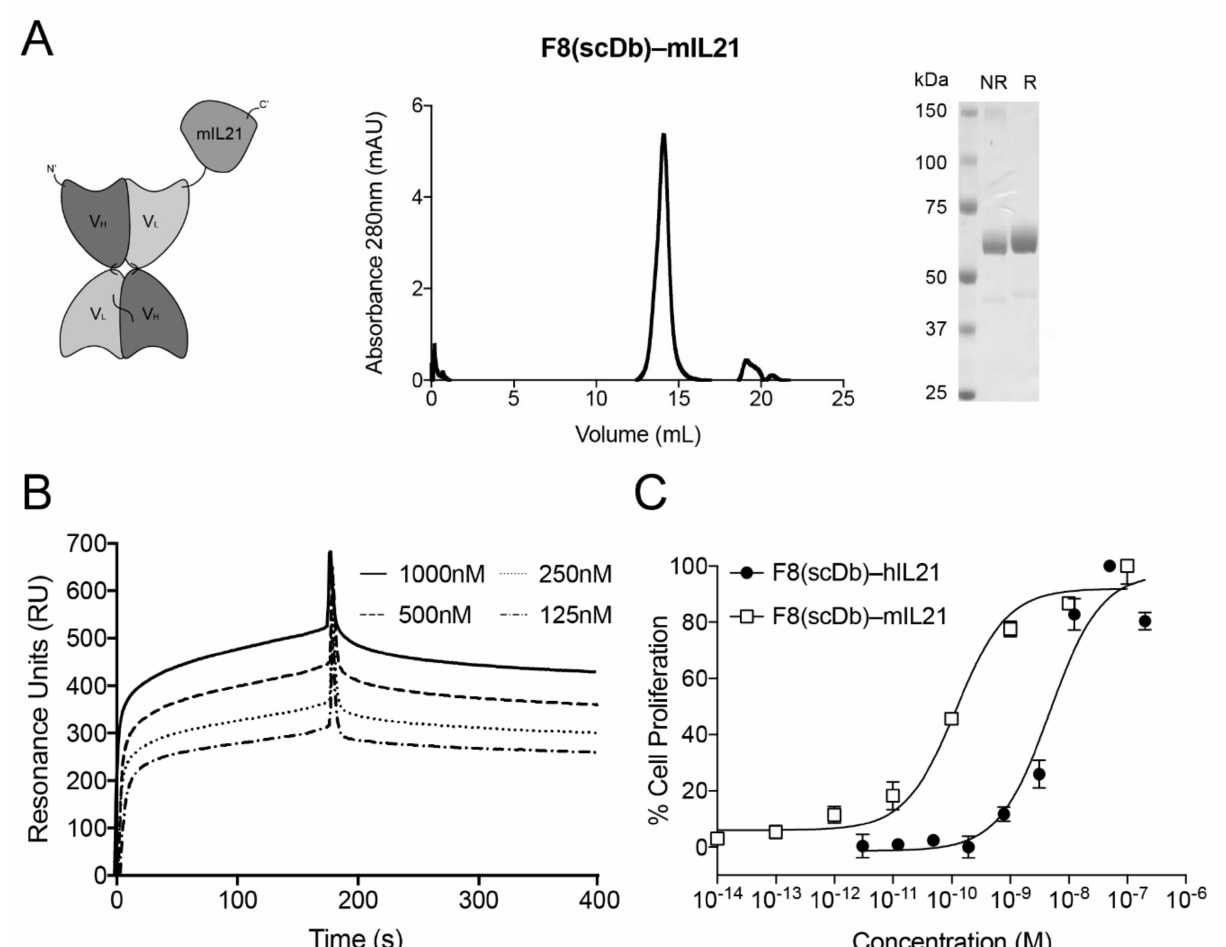
Figure 2. In vitro characterization and biological activity of murine and human variant in single chain diabody format with IL21 fused at the C-terminus. ( A ) F8(scDb)-mIL21; size exclusion chro- matography profile; SDS-PAGE (NR, non-reducing condition; R, reducing condition). ( B ) SPR on EDA-coated chip of F8(scDb)-IL21. ( C ) Activity assay based on CTLL2 cell proliferation by exposure to F8(scDb)-mIL21 and F8(scDb)-hIL21 fusion